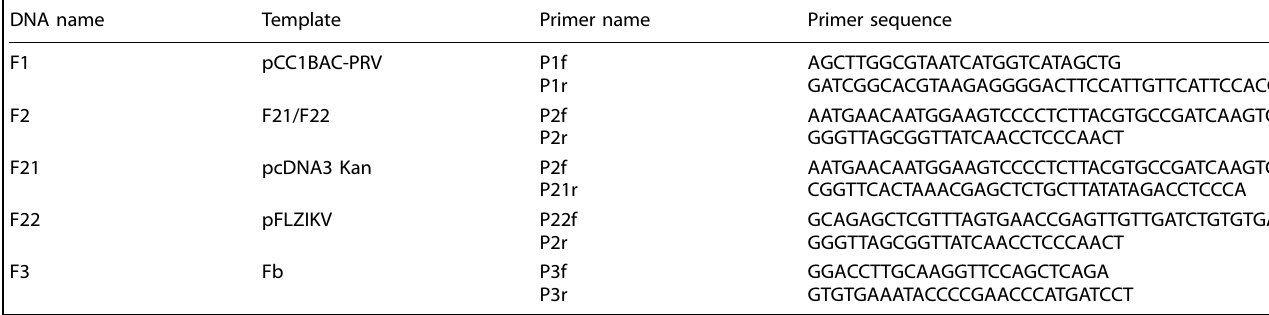
Table 2. DNA fragments generated by PCR for ZIKV WT cloning to yield